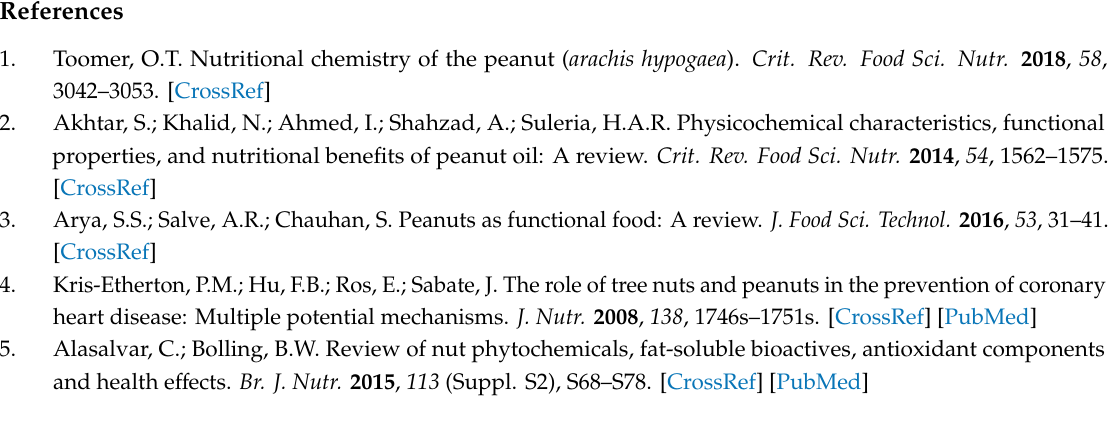
Figure S1: The weighted proportion of cardiovascular disease or diabetes mellitus by peanut intake groups. Figure S2: The weighted proportion of the highest quartile of dietary pattern score by peanut intake groups in men (A) and women (B). Figure S3: Principal component analysis plots of three principal components. Table S1: Component foods of the 13 food groups. Table S2: Sex-stratified sociodemographic characteristics of study participants according to frequency of peanut consumption. Table S3: Sex-stratified dietary characteristics of study population according to frequency of peanut consumption. Table S4: Factors associated with frequent peanut consumption in Korean stratified by sex. Table S5: Factors associated with frequent peanut consumption in Koreans stratified by history of cardiovascular disease or diabetes